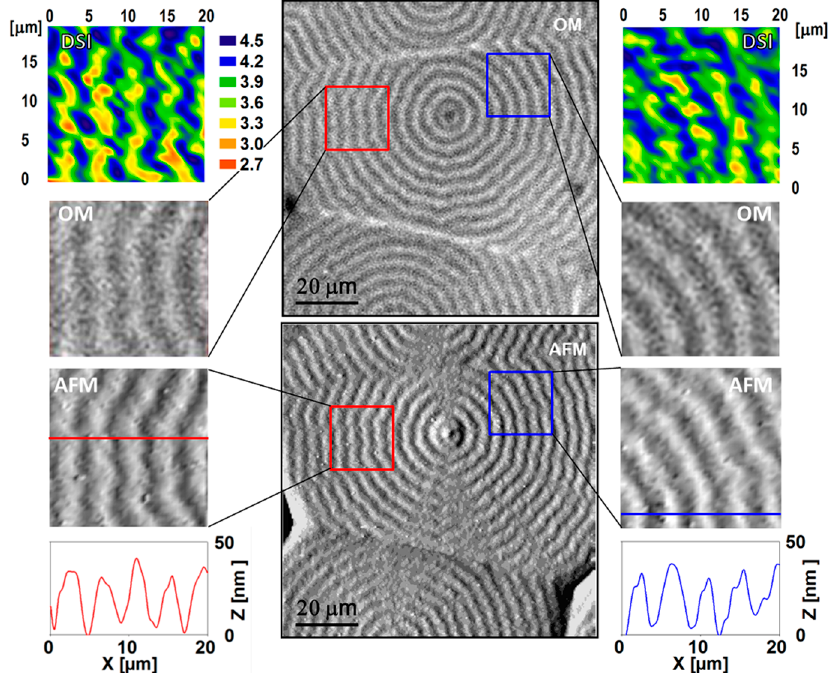
Figure 5. Central part: P3HB-co-3HV spherulites grown after crystallization at T = 65 °C. The images were taken using OM (top) and AFM (bottom). Enlargements of the two areas selected for analysis (20 × 20 μ m 2 ) are shown on the left- and right-hand sides, together with the E ′ contours constructed by interpolating the mesh of indentation data (top) and the AFM height profiles (bottom) across the lines indicated in the enlarged AFM images. The E ′ color code appearing next to the contour map on the left-hand side has also been used for the contour map on the right-hand side (units in GPa).